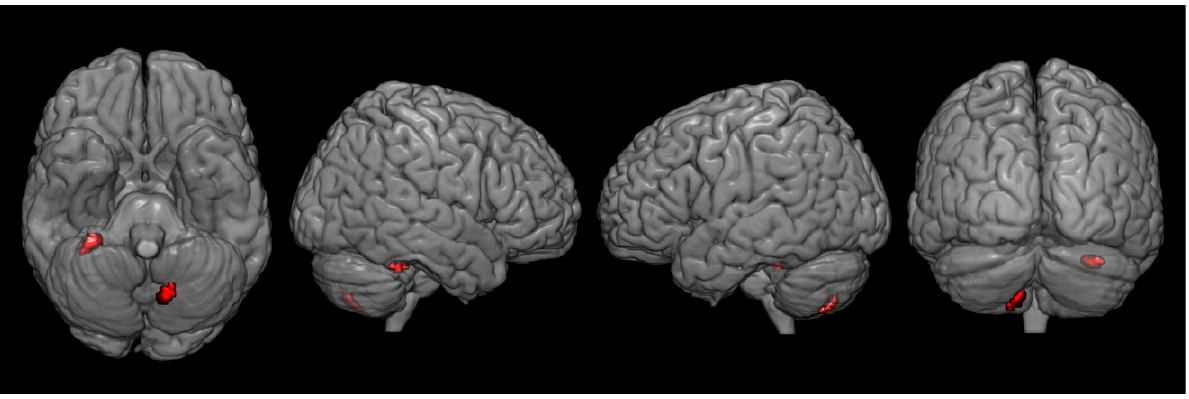
Figure 4. Spatial distributions of increased glucose metabolism in the central post-stroke pain group following pontine hemorrhage compared with that in the control group. ( P uncorrected < 0.001, k = 10). Table 3. Area of the brain that showed altered glucose metabolism in patients with central post-stroke pain following pontine hemorrhage.